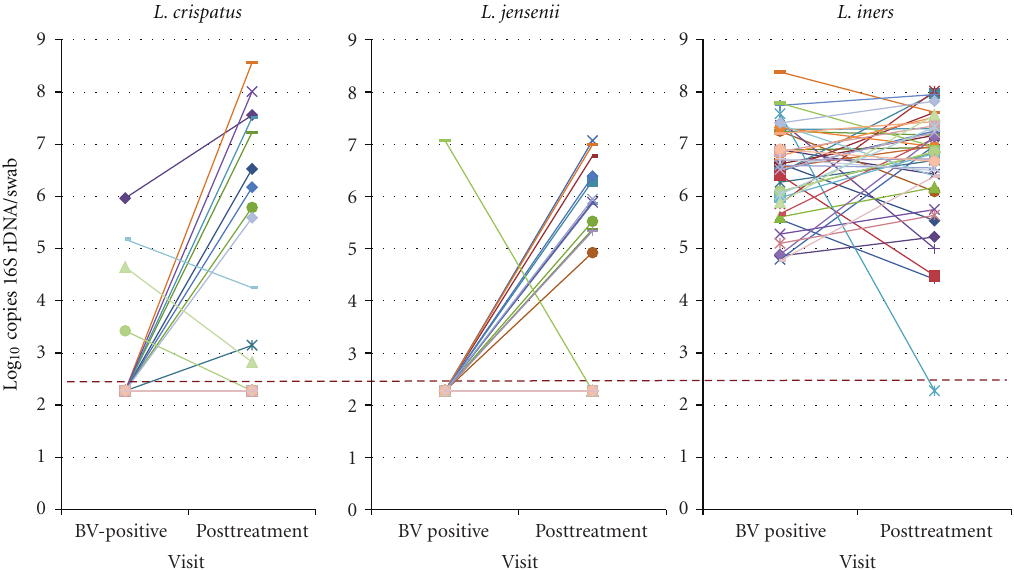
Figure 1: Change in concentrations of three di ff erent species of lactobacilli, as measured by species-specific quantitative PCR, 4 weeks after treatment for bacterial vaginosis with vaginal metronidazole. Each line represents an individual patient and her concentration of each bacterium before and after treatment. The dotted line represents the lower limit of detection of the qPCR